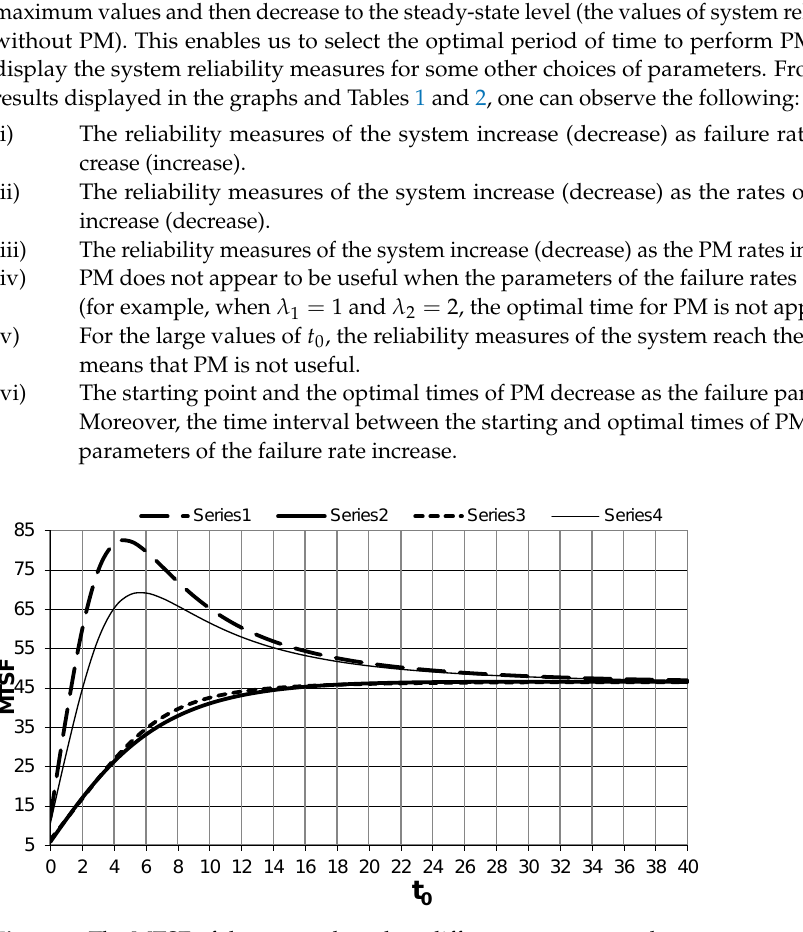
Figure 2. The MTSF of the system based on different parameter